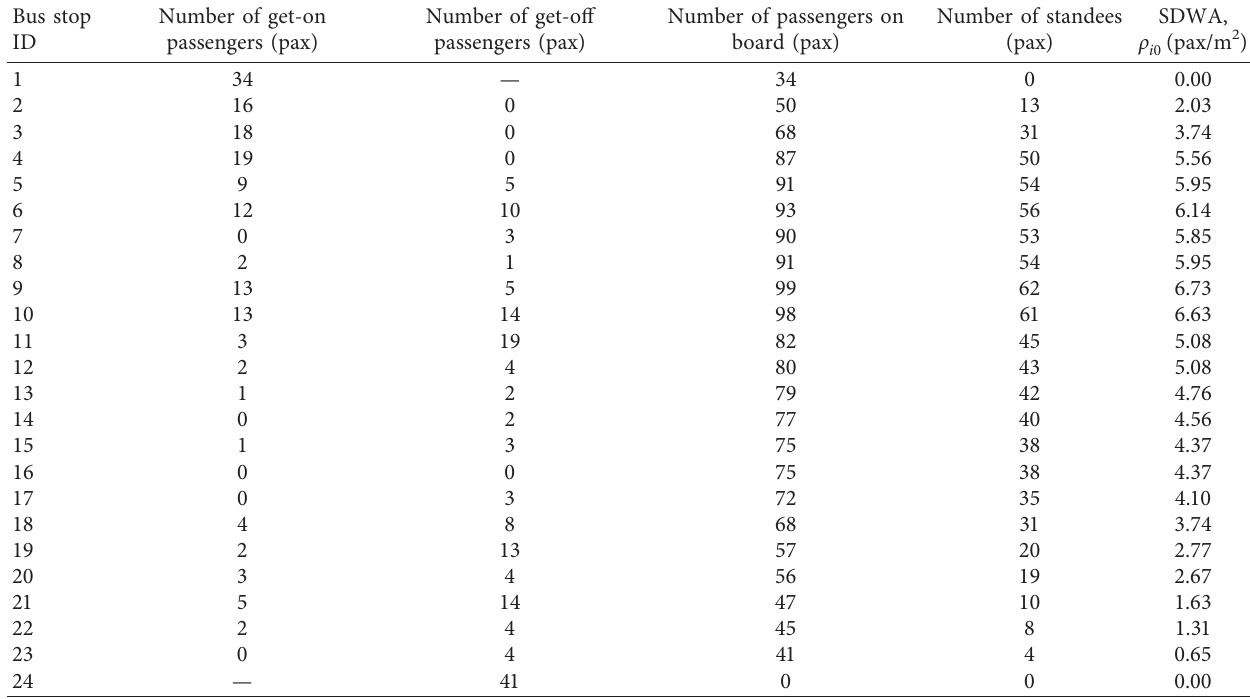
Table 5: Passenger flow data collected during peak